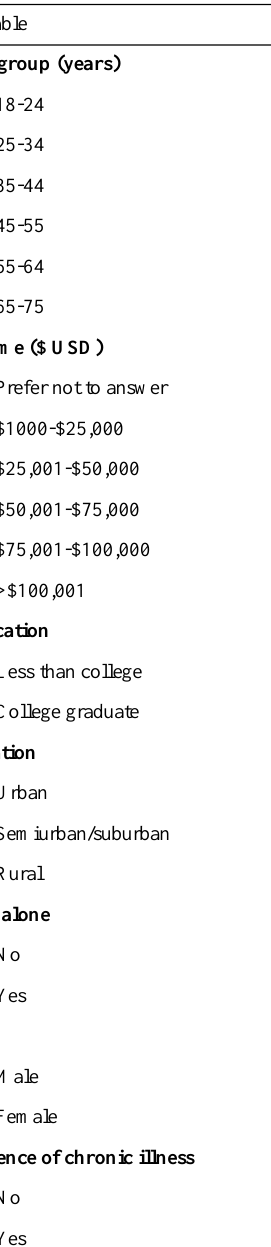
Table 1. Descriptive statistics from the sample of 1681 observations showing frequencies and percentages in different